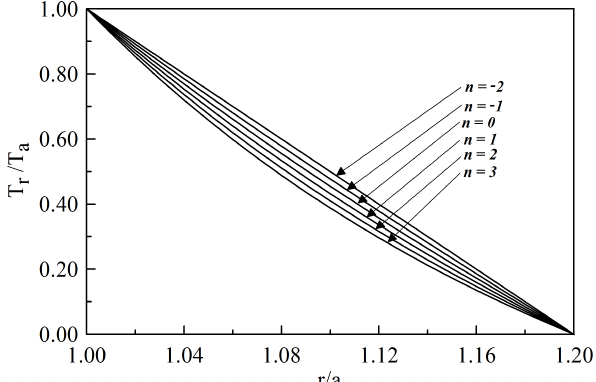
Figure 16: Radially distributed temperature